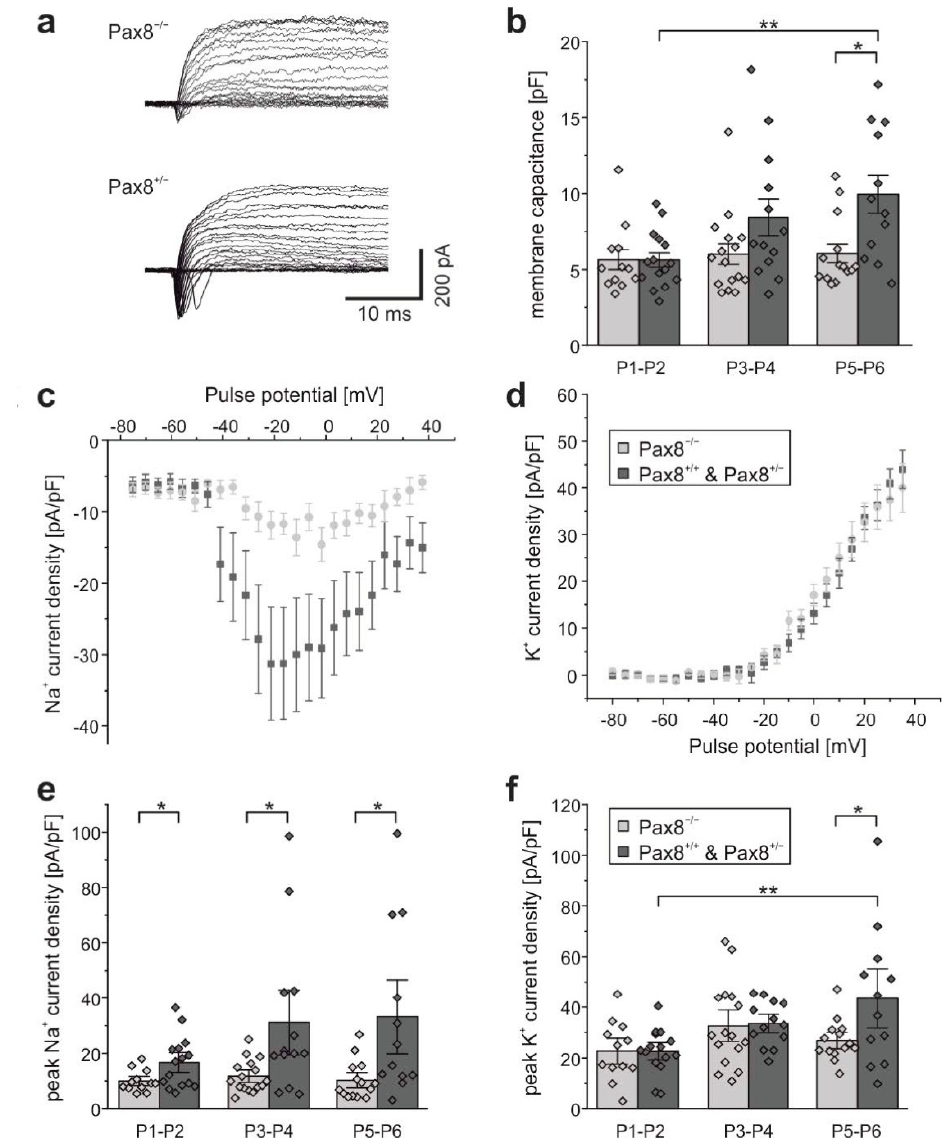
Figure 2. Na + and K + currents in Pax8 +/ − and Pax8 − / − mice. ( a ) Exemplary series of original Na + and K + current recordings from acutely dissociated neurons elicited by step depolarizations in 5 mV increments starting from a holding potential of − 80 mV (after liquid junction correction). Traces from P3–P4 hippocampal neurons obtained from a Pax8 − / − mouse (top) and from a Pax8 +/ − mouse (bottom). ( b ) Membrane capacitances calculated from the integral of the charging curve for a test potential step of 20 mV. Bars represent means ± SEM; single data points shown as diamonds. Average current